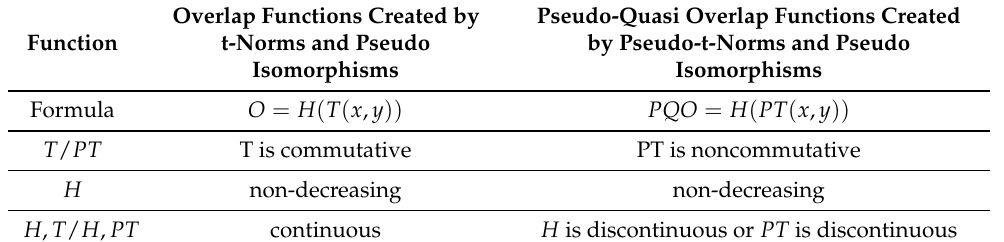
Table 2. Overlap functions created by t-norms and pseudo isomorphisms and pseudo-quasi overlap functions created by pseudo-t-norms and pseudo isomorphisms. Overlap Functions Created by Pseudo-Quasi Overlap Functions Created Function t-Norms and Pseudo by Pseudo-t-Norms and Pseudo Isomorphisms Isomorphisms Formula O = H ( T ( x , y )) PQO = H ( PT ( x , y )) T / PT T is commutative PT is noncommutative H non-decreasing non-decreasing H , T / H , PT continuous H is discontinuous or PT is